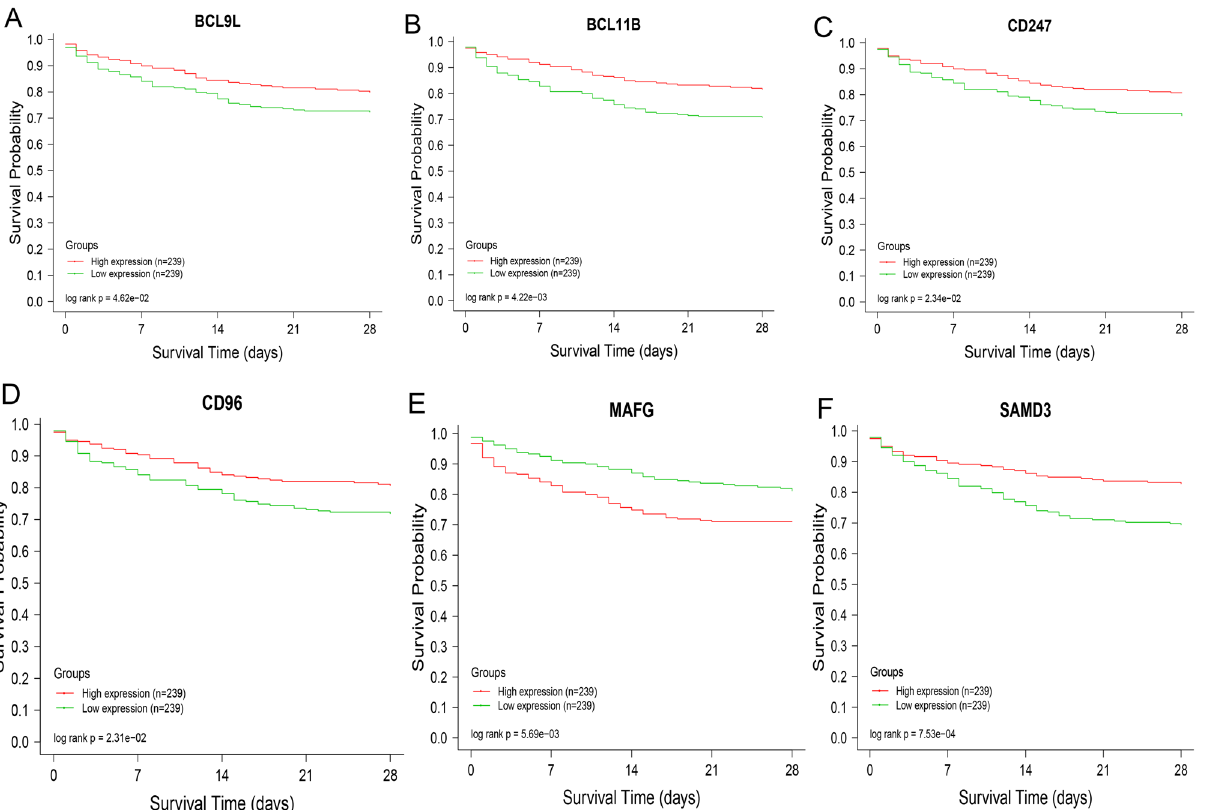
Figure 4. Survival curve of key genes. a-f showed 28-day temporary survival curves of BCL9L, BCL11B, CD247, CD96, MAFG and SAMD3, respectively (according to GSE65682), suggesting a positive correlation between these 5 pivotal genes and the survival rate of sepsis, except that MAFG showed negative correlation with survival rate. Red color as a high expressed group; Green color as a low expressed group. Horizontal ordinate as timepoints within 28 days; Vertical ordinate as survival rate. Log-rank statistical analysis showed that P BCL9L = 0.0462, P BCL11B = 0.00422, P CD247 = 0.0234, P CD96 = 0.0231, P MAFG = 0.00569 and P SAMD3 =